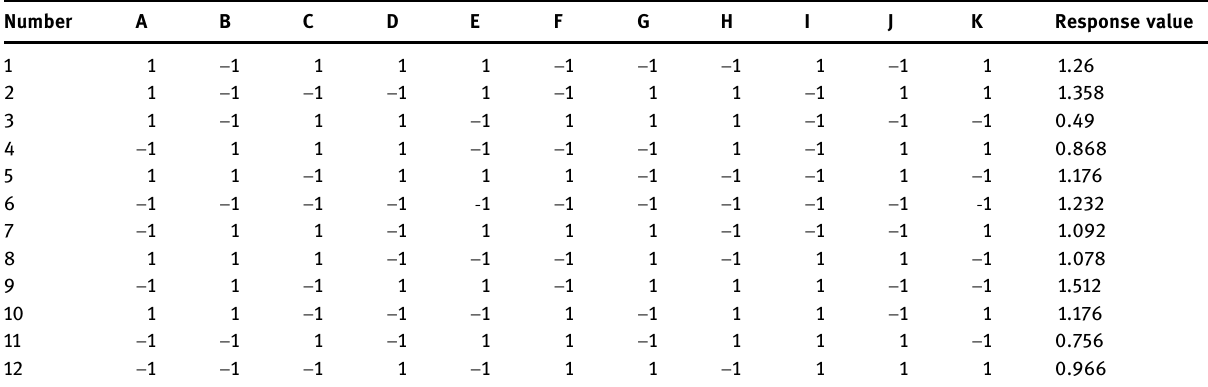
Table 2: Plackett – Burman experimental design and response